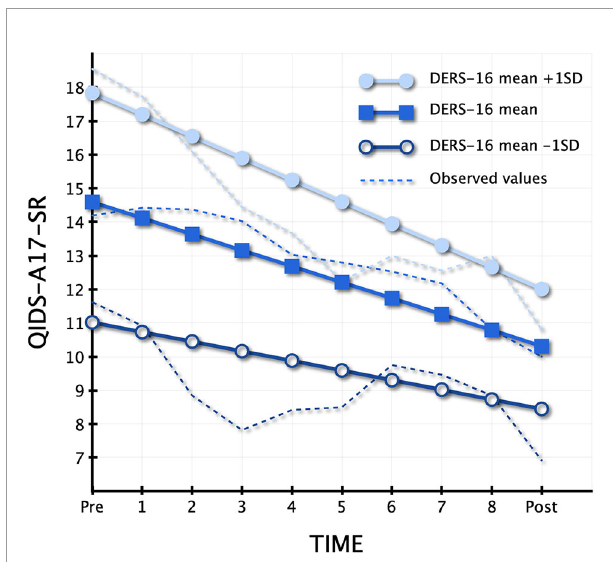
FIGURE 1 | Different trajectories of change depending on baseline value on Dif fi culties in Emotion Regulation Scale